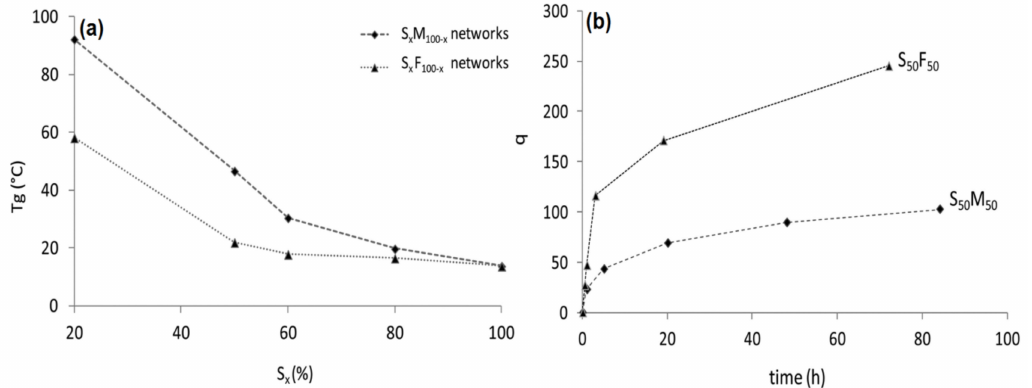
Figure 11. ( a ) Variation of T g values with sunflower oil contents in β -myrcene and β -farnesene networks. ( b ) Swelling rate of S 50 M 50 and S 50 F 50 films in eugenol. Sample designations: ‘S’ stands for sunflower oil, ‘M’ represents β -myrcene, ‘F’ indicates β -farnesene and S:M / S:F (number in the parentheses) represents polymer network composition. (Reproduced from Reference 84, with permission from American Chemical